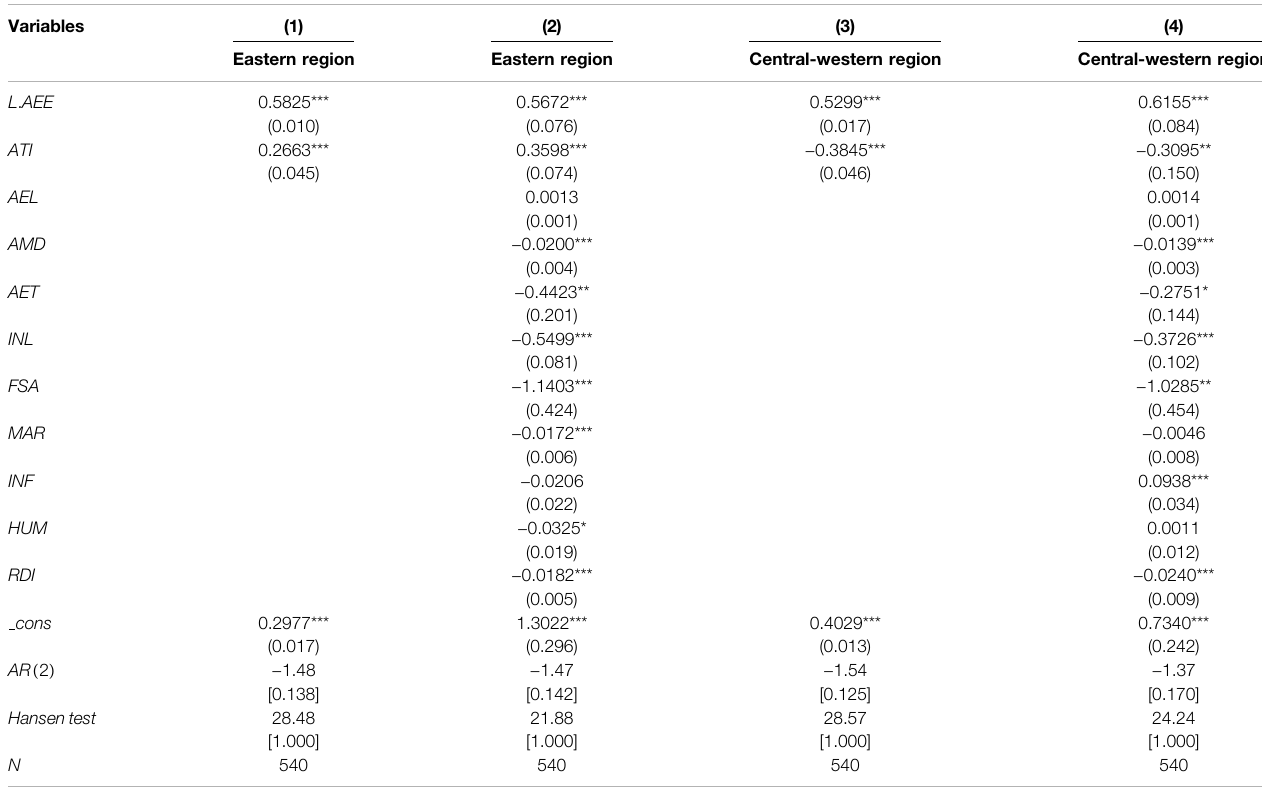
TABLE 4 | Regional heterogeneity results.